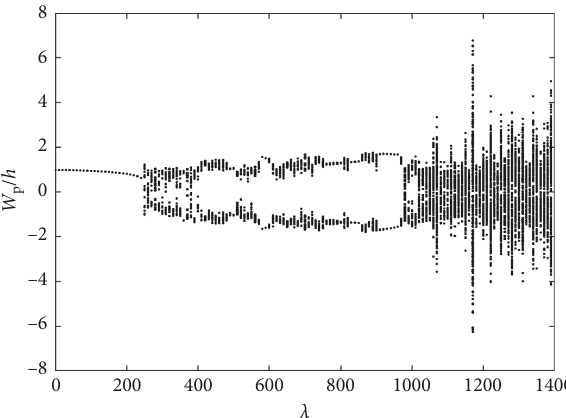
Figure 5: Bifurcation diagram versus dynamic pressure for H / h � 0 . 2and Δ T / Δ T